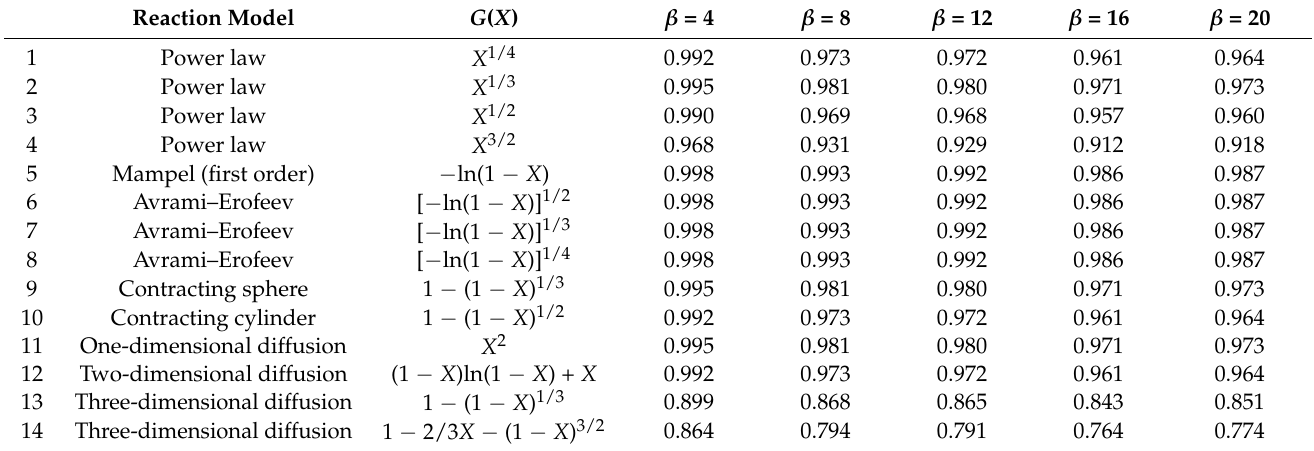
Table 4. Linear coefficient of determination R 2 values obtained with respect to ln[ G ( X )] and 1000/ T using Equation (5) for 0.2 < X ≤ 0.8 at various heating rates β (K · min − 1 ) and integral functions G ( X ).